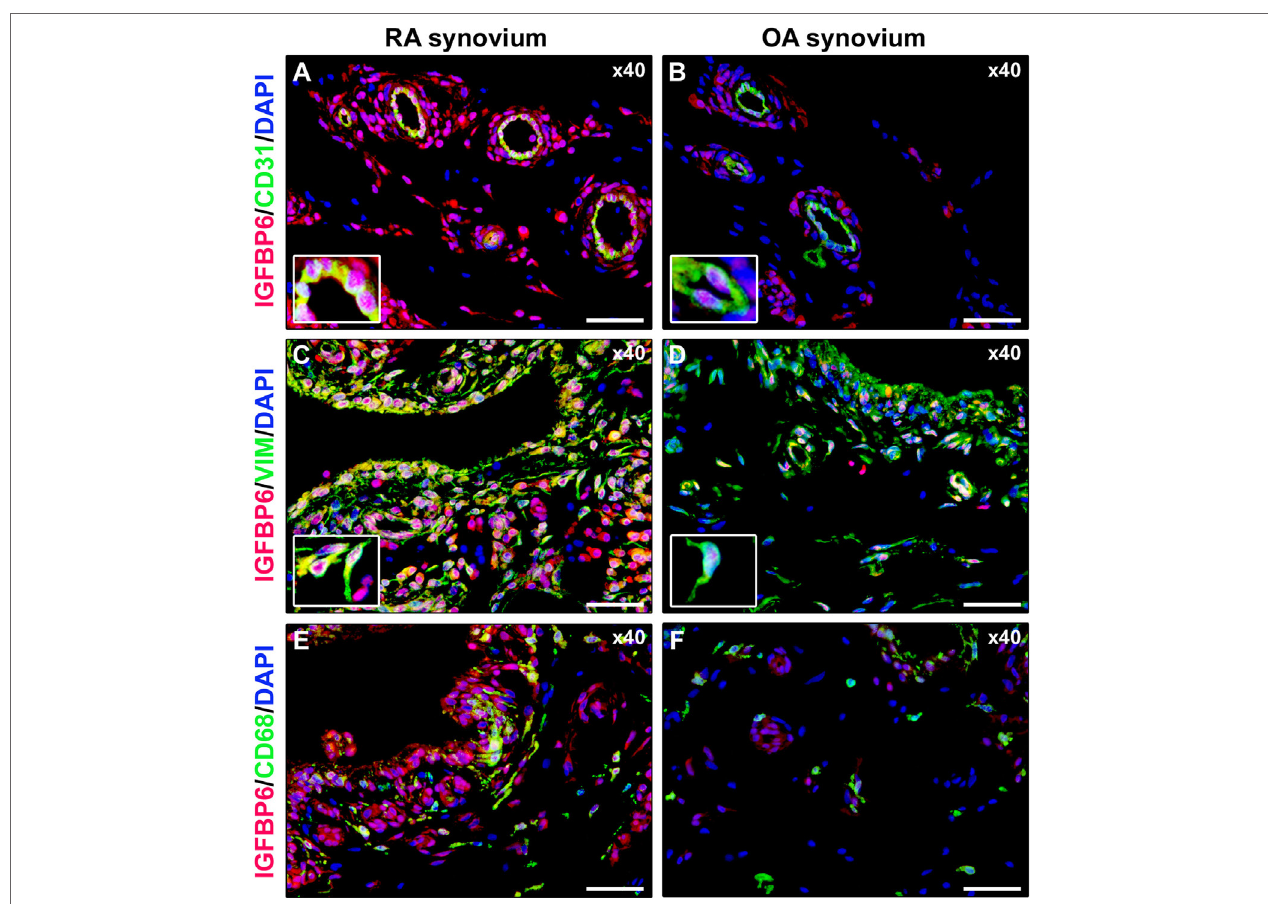
FigUre 4 | insulin-like growth factor binding protein 6 (igFBP6) expression in different synovial resident cell types . Representative microphotographs of synovial sections from rheumatoid arthritis (RA) patients (a,c,e) and osteoarthritis (OA) controls (B,D,F) subjected to double immunofluorescence staining for IGFBP6 (red) and the pan-endothelial cell marker CD31 (green) (a,B) , the fibroblast marker VIM (green) (c,D) , or the macrophage marker CD68 (green) (e,F) . Nuclei are counterstained with 4 ′ ,6-diamidino-2-phenylindole (DAPI; blue). In RA synovium, IGFBP6 is strongly expressed in CD31 + vascular endothelial cells (a) , VIM + fibroblast-like synoviocytes (FLS) (c) , and CD68 + macrophages (e) . Weak IGFBP6 immunopositivity is detectable in the same cell types of OA synovium (B,D,F) . Insets: higher magnifications of double-immunopositive cells from the respective panels. Note the intense immunopositivity for IGFBP6 localized either in the cytoplasm or in the nucleus of RA synovial endothelial cells and FLS. Original magnification: × 40 (a–F) . Scale bar: 50 µm (a–F)